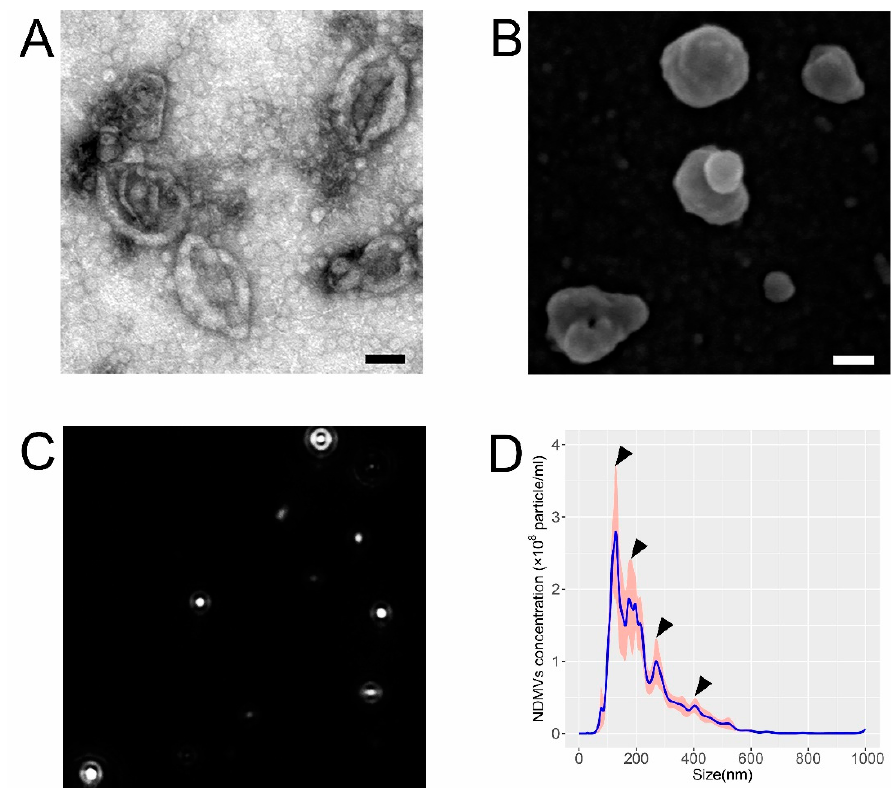
Figure 1. Properties of NDMVs isolated by ultra-centrifugation from TNF α -treated neutrophils. ( A ) NDMVs displayed a cup-shaped appearance in TEM after visualization by negative staining. ( B ) NDMVs appear as irregular spheres with a non-smooth surface in SEM. Scale bar in ( A , B ) = 100 nm. ( C ) Screenshot of NTA video that records Brownian motion of NDMVs with highlighted white dots for demonstrating particle size and concentration distribution from one sample in one experiment. ( D ) Size distribution of NDMV size ranging from 100 to 1000 nm after measurements by NTA from 5 separate experiments. The solid line represents the mean concentrations of differently sized NDMVs, with the gray and pink shading showing standard error (SE) of the means ( n = 5). Arrows indicate each sub-population.